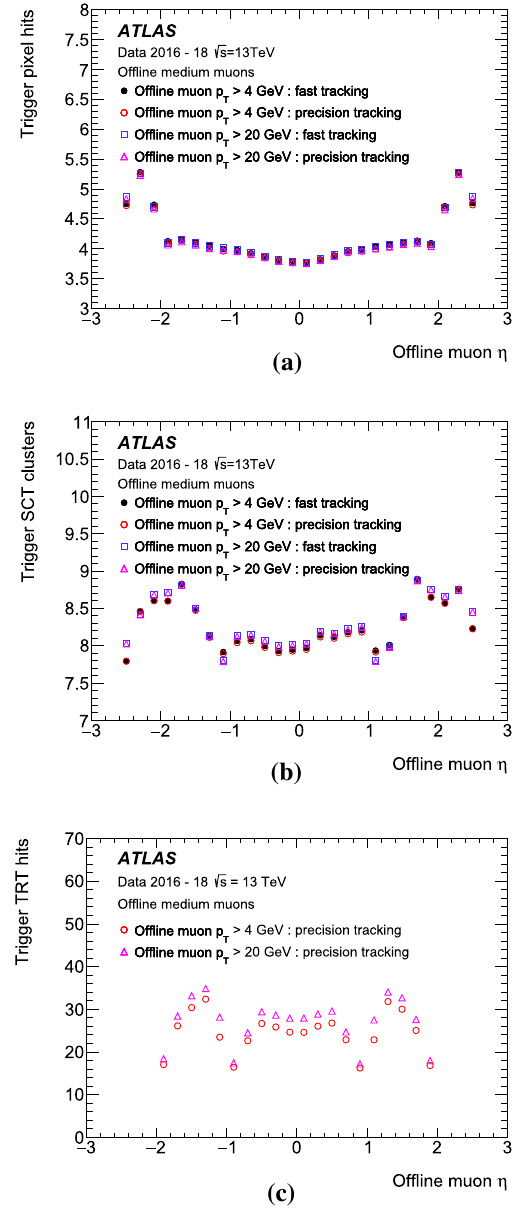
Fig. 19 The mean multiplicities for a pixel, b SCT, and c TRT hits on trigger tracks matched to offline tracks as a function of the matching offline track pseudorapidity. Shown are the hit multiplicities for the precision and fast tracking for the pixel and SCT. The TRT extension does not run for the FTF tracks and so the multiplicity for the FTF is not shown in c